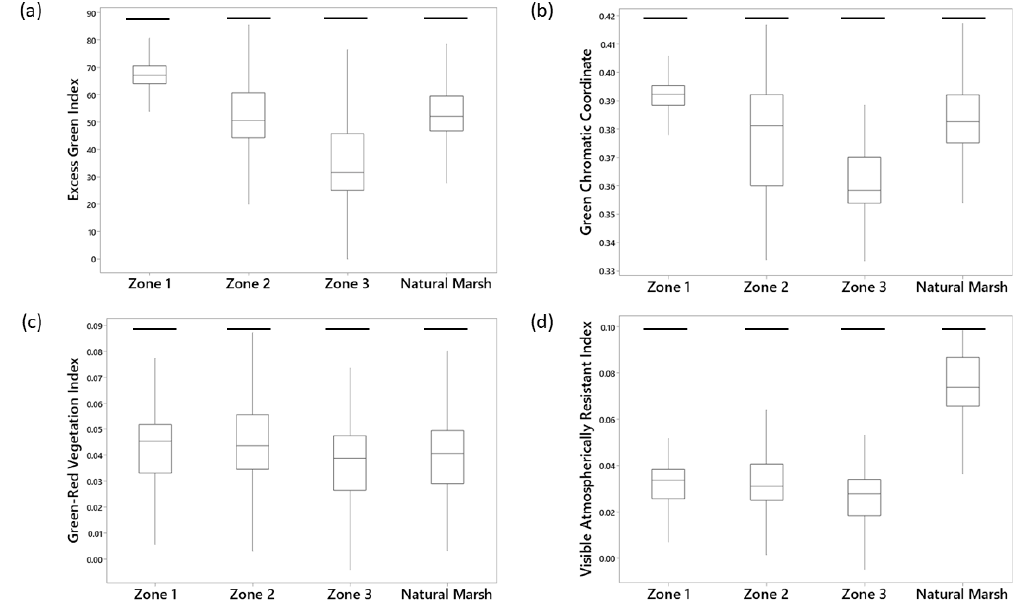
Figure 5. Distribution of vegetation indices for ( a ) Excess Green Index, ( b ) Green Chromatic Coordinate, ( c ) Green-Red Vegetation Index, and ( d ) Visible Atmospherically Resistant Index. All vegetation indices were significantly different ( p < 0.01) in all zones.